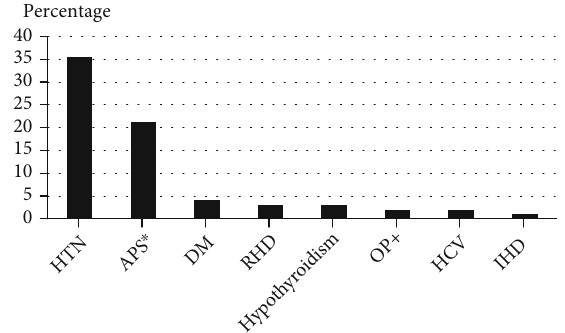
Figure 2: The frequency of comorbidities among the lupus cohort. HTN: systemic hypertension; APS: antiphospholipid syndrome; DM: diabetes mellitus; RHD: rheumatic heart disease; OP: osteoporosis; HCV: hepatitis C virus; IHD: ischemic heart disease. ∗ The Sydney classi fi cation criteria were used [41]. † Diagnosis of osteoporosis was based on a patient ’ s low bone mineral density in comparison to that of a healthy adult of matched age and sex plus the presence of an osteoporotic fracture(s)